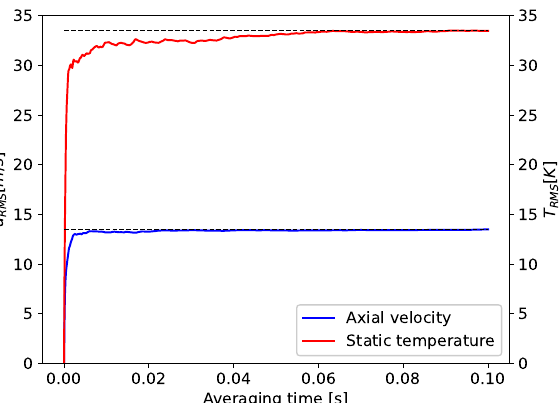
Figure 3. Spatial averages of the RMS values for the axial velocity and static temperature at the turbine inlet as a function of the averaging time. The black dashed lines correspond to the final value for an averaging time of 0.1